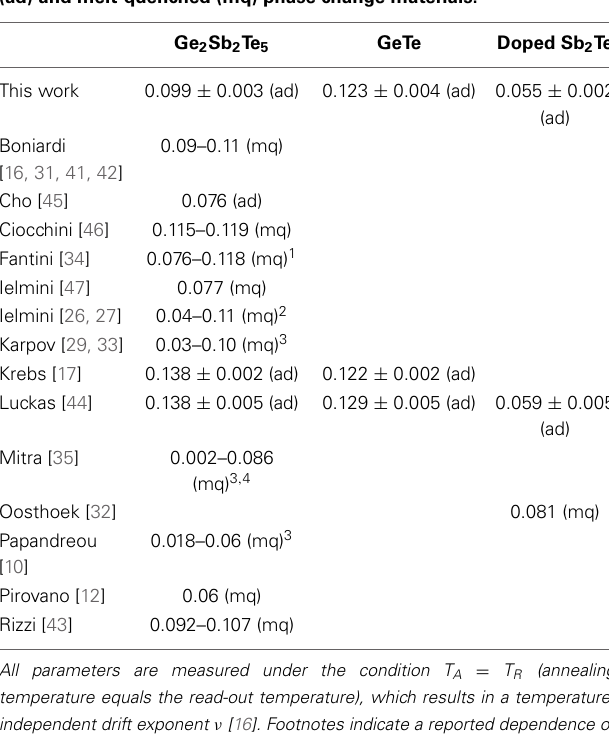
Table 1 | Collection of drift parameters for amorphous as-deposited (ad) and melt-quenched (mq) phase change materials.